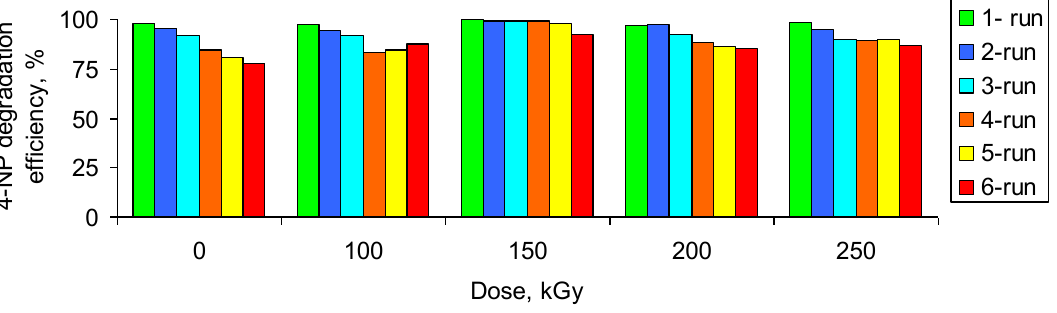
Figure 5. Changing of conversion of the 4-NP for six reaction runs in the presence of Cu NTs PET TeMs composite membranes before and after e-beam treatment.